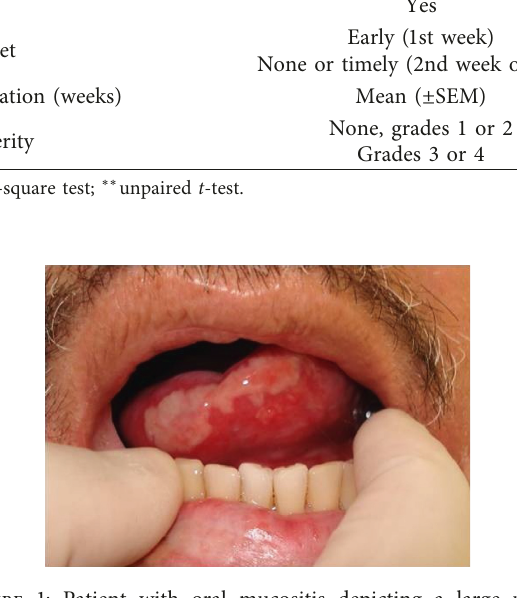
Figure 1: Patient with oral mucositis depicting a large ulcer covered by fibrin pseudomembrane on the left side of the tongue. The lesion was painful, and the patient was unable to eat solid foods (grade 3 on WHO scale